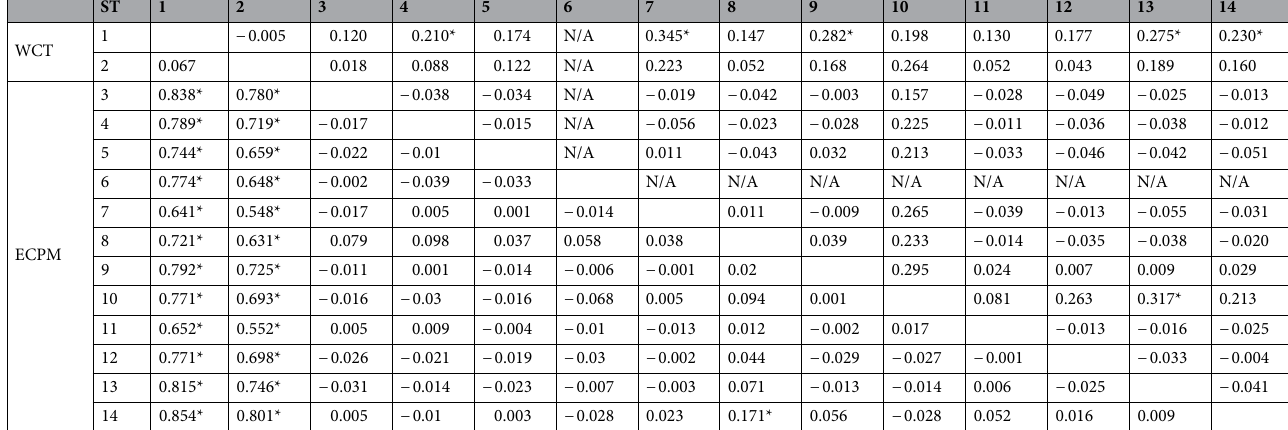
Table 2. Population pairwise comparison Ф ST among 14 sampling stations (ST) of Uranoscopus cognatus inferred from the partial CO1 (below diagonal) and RAG1 regions (above diagonal). *Significant at P < 0.05.